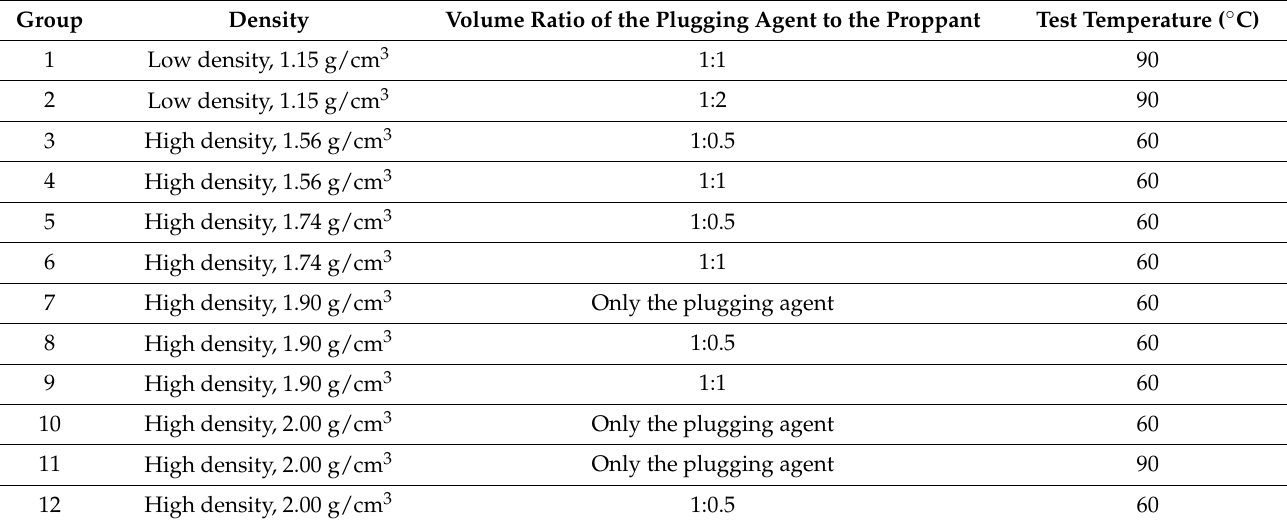
Table 2. Parameters of the different experimental groups.